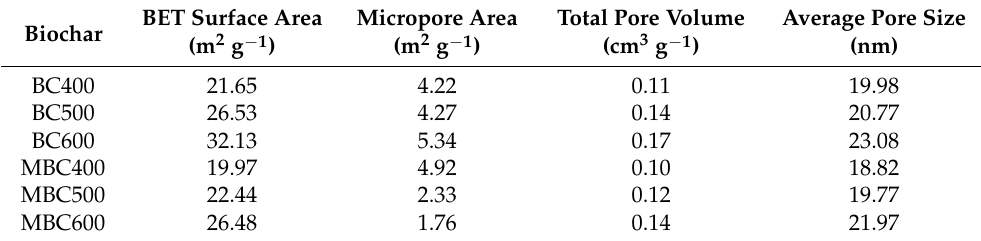
Table 2. Surface structural characteristics of BCs and MBCs. BET—Brunauer–Emmett–Teller.